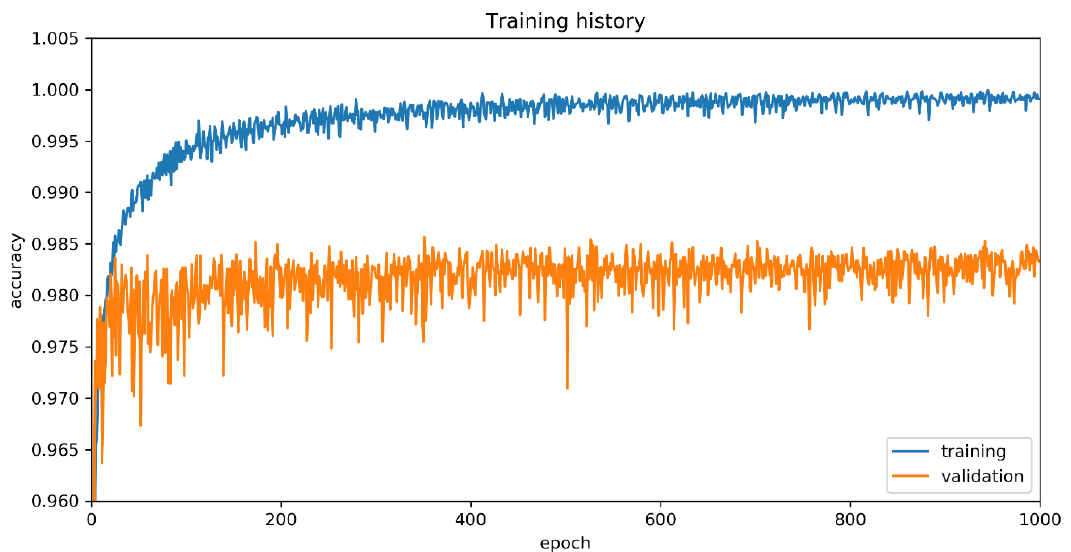
Figure 6. Training history of 1000 epochs iteration of CNN model as described in Table 2. The blue curve is the classification accuracy of the training data. The orange curve is the classification accuracy of the testing data. There is a visible gap around 1.5% between the two curves.